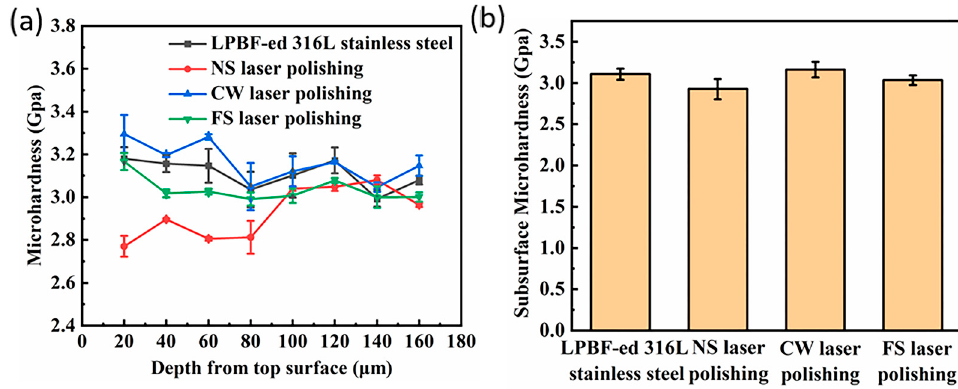
Figure 8. ( a ) Microhardness distributions and ( b ) average hardness of original and laser-polished samples.